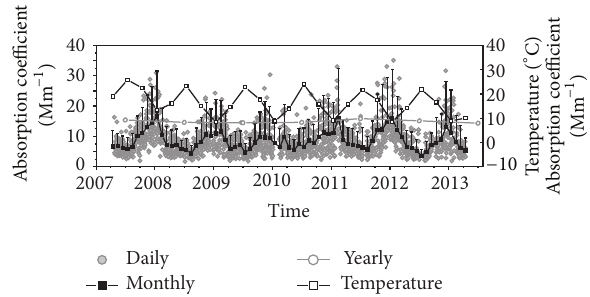
Figure 2: Time series of the absorption coefficient (daily and monthly values in the left scale; yearly values in the right scale) and seasonal temperature measured in ´Evora between April 2007 and April